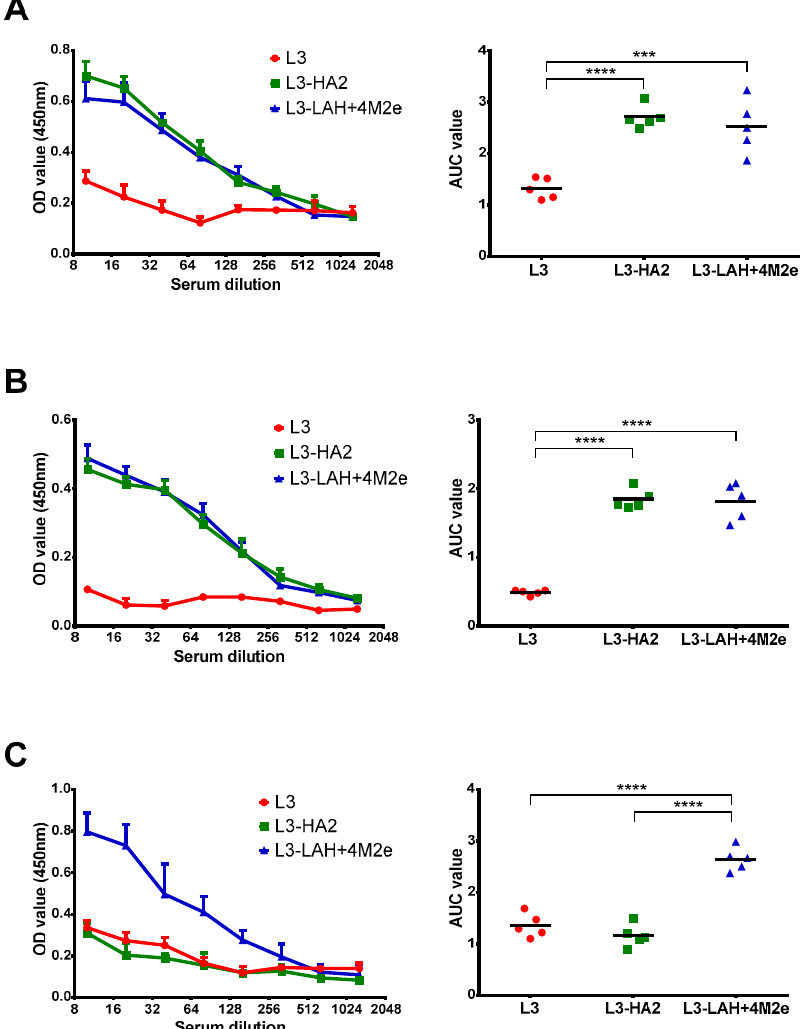
Figure 3. Serum IgG antibody immune responses after vaccination. Mouse sera were collected three weeks after third immunization. Sera were treated with L3-enterococci and then IgG antibody levels were assessed in ELISA against different influenza virus antigens: cH6/1 chimeric HA protein ( A ), LAH recombinant protein ( B ) and 3M2e recombinant protein ( C ). Left panel shows mean OD 450 values for each serum dilution. Right panel shows the area under the OD 450 curve values for each individual animal. Data were analyzed by one-way ANOVA with Tukey’s post-hoc multiple analyses test. ***— p < 0.001; ****— p < 0.0001.